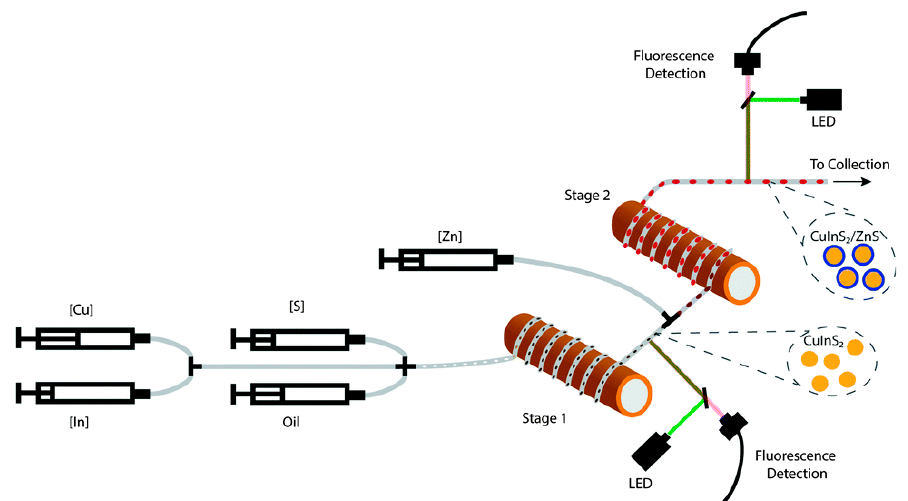
Figure 8. Two-stage droplet-based microfluidic platform for the controlled synthesis of CuInS 2 /ZnS NCs [68].